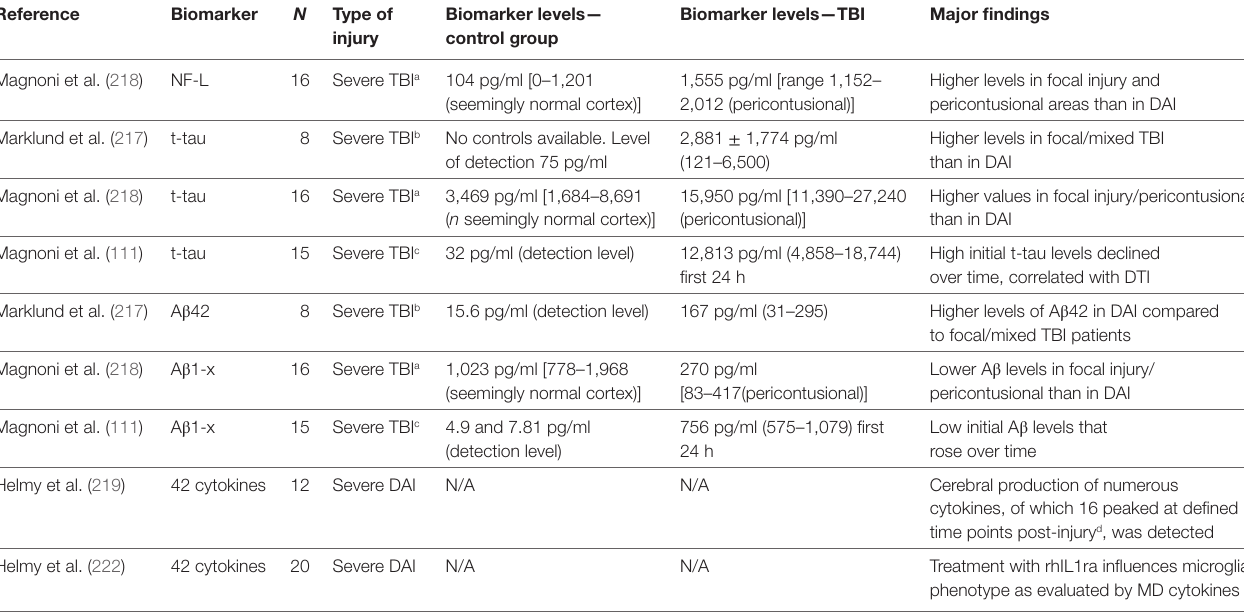
TABLe 2 | Results from cerebral microdialysis (MD) studies of commonly used biomarkers for monitoring axonal injury in clinical